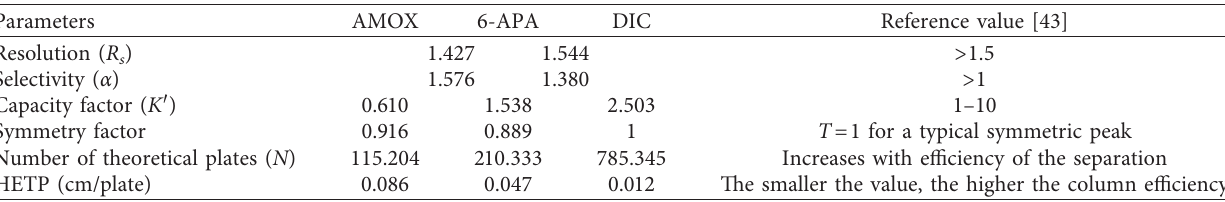
Table 5: Parameters of system suitability of the developed HPLC method for the determination of AMOX and DIC with their common impurity, 6-APA.